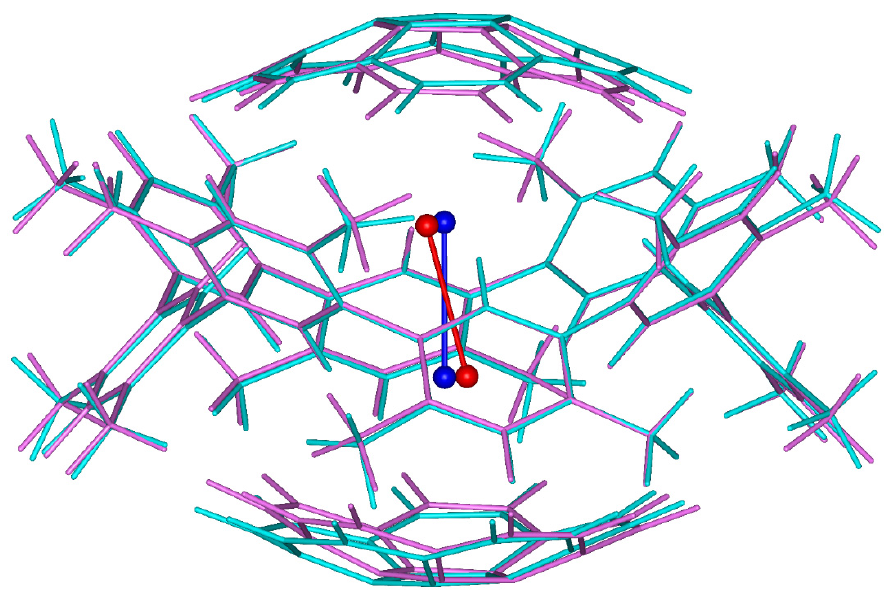
Figure 1. Initial and final geometries of the tetramer discussed in the text. Color coding of the initial/final structures: blue/red for molecular iodine, cyan/magenta for the rest of the atoms.